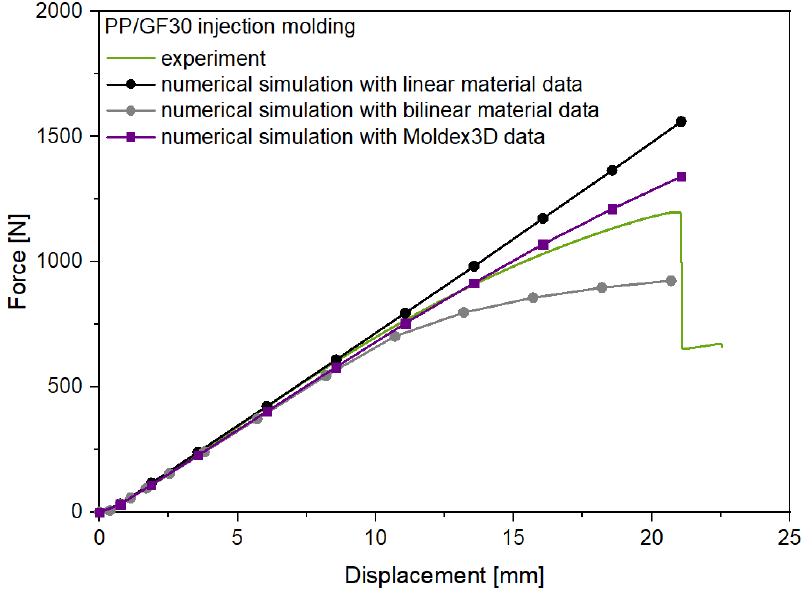
Figure 15. Experimental and numerical results for the flexural test of the PP/GF30 short fiber-rein- forced thermoplastic composites test